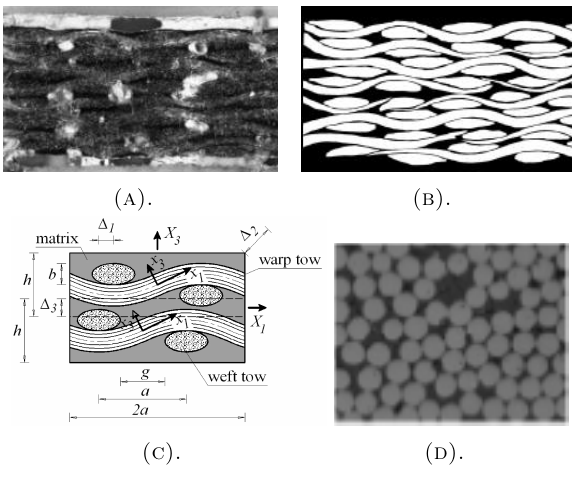
Figure 3. (A) mesoscopic 2D image of basalt fiber/ceramic matrix plain weave textile composite, (B) binary image of the 8-layer laminate cross-section, (C) description of two-layer SEPUC on the mesoscale, (D) example of a real structure of